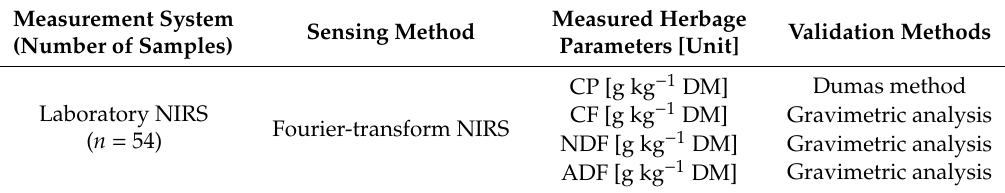
Table 2. Herbage parameters determined by the laboratory NIRS with the respective wet-chemical methods for